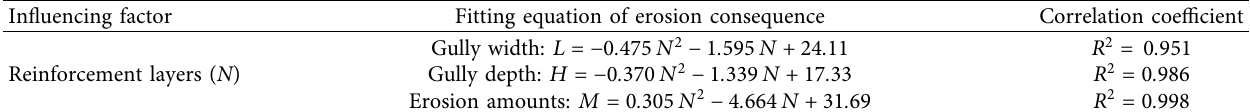
Table 6: Effect of reinforcement layers on erosion disaster consequence.